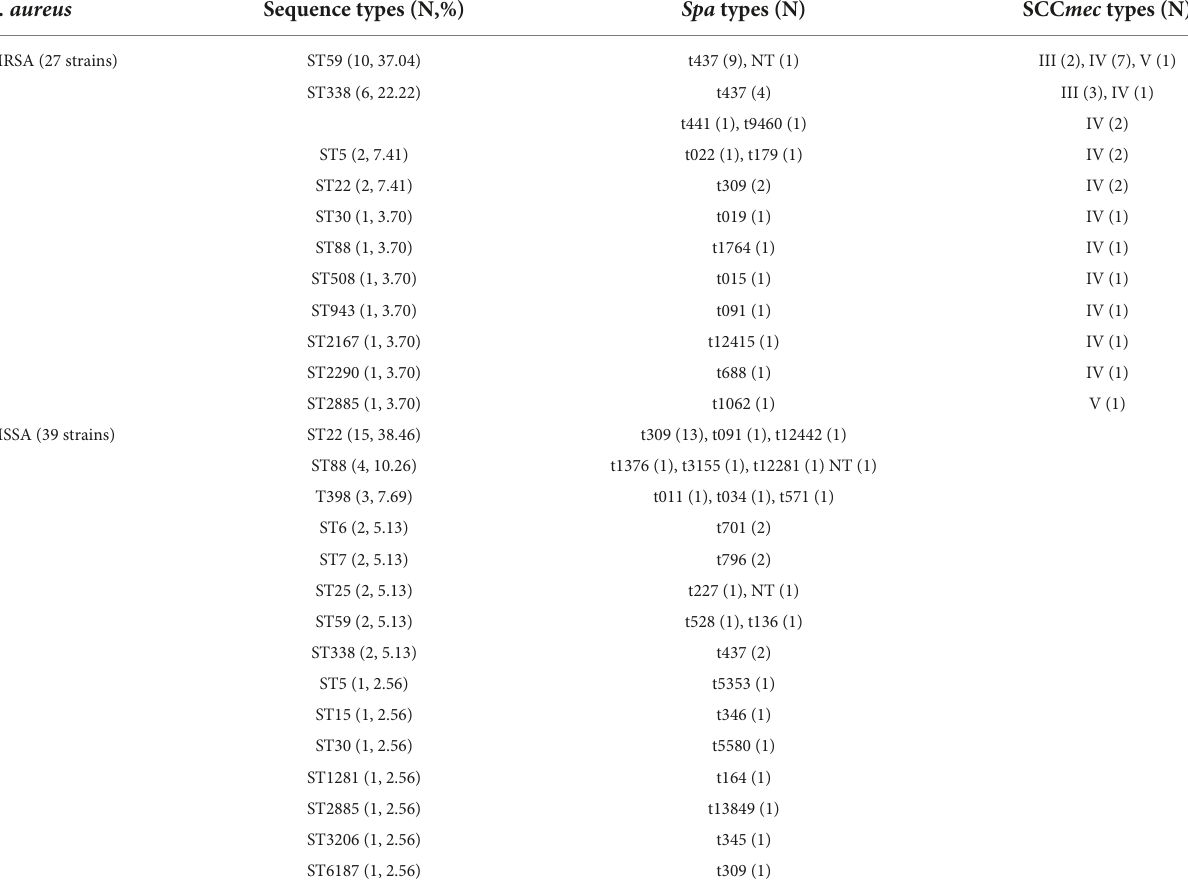
TABLE 2 Molecular characteristics of 66 invasive Staphylococcus aureus